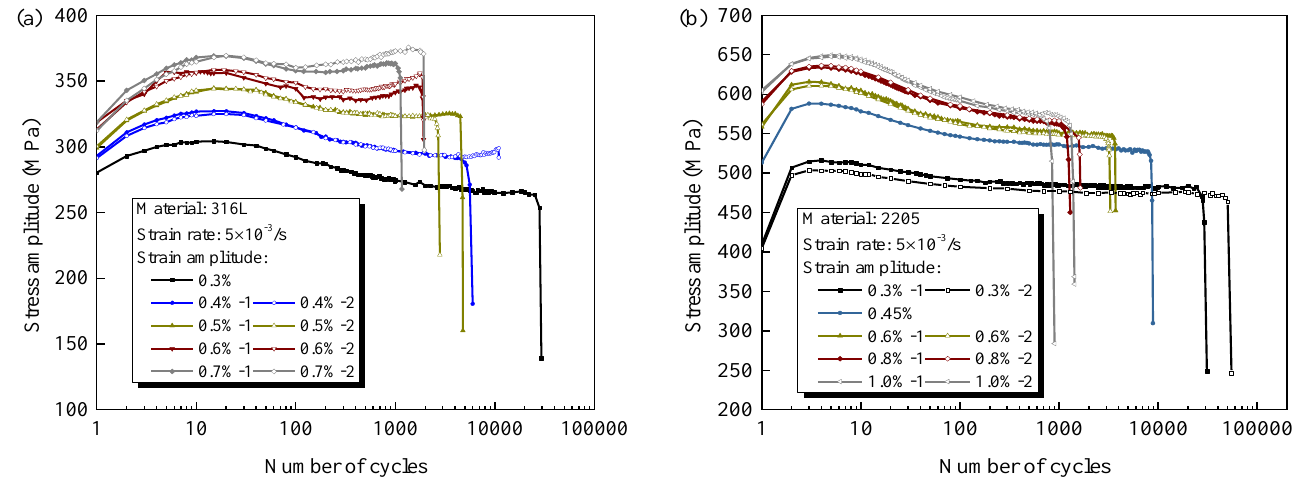
Figure 4. Cyclic stress amplitude for ( a ) 316L and ( b ) 2205 under different strain amplitudes with a constant strain rate of 5 × 10 −3 s −1.